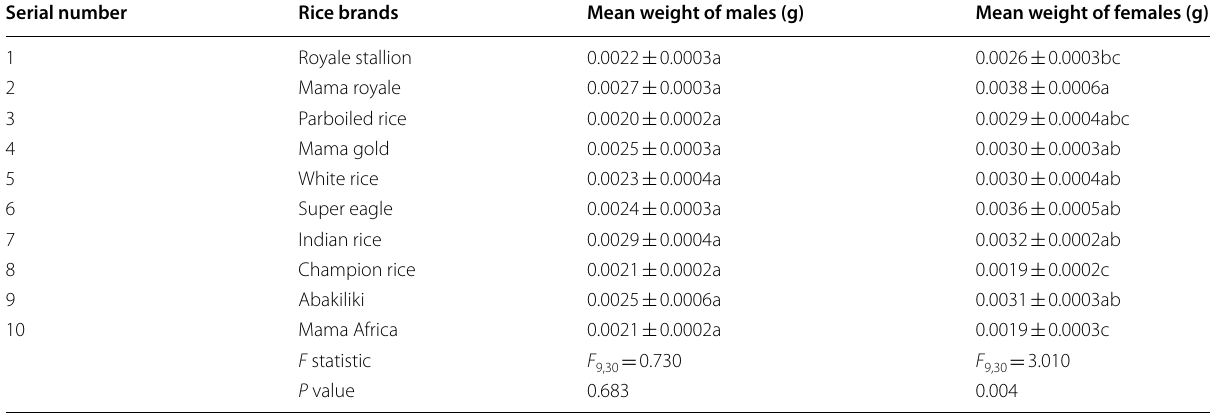
Data are means SEM of four replications ± Mean values in a column with same letter are not significantly different by HSD ( α